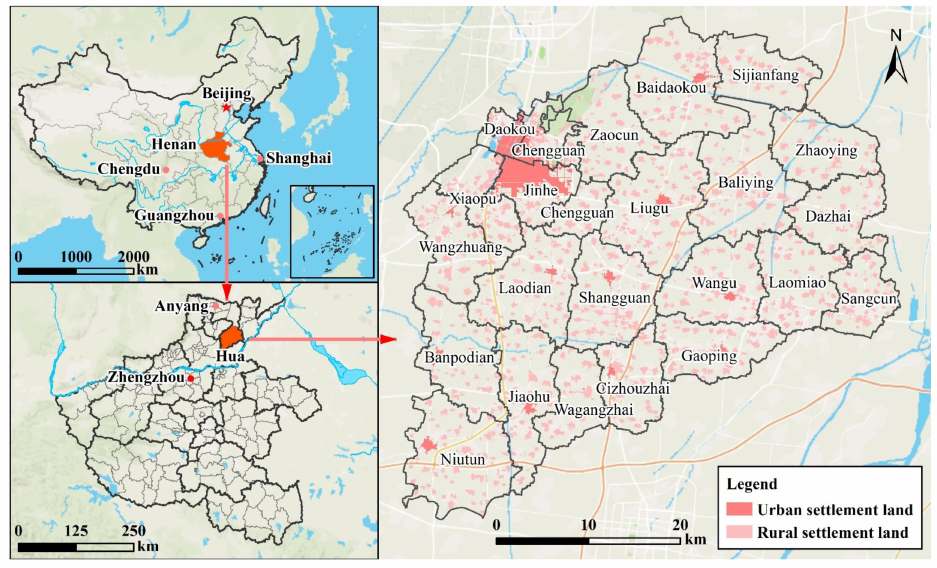
Figure 3. Location and land use of the study